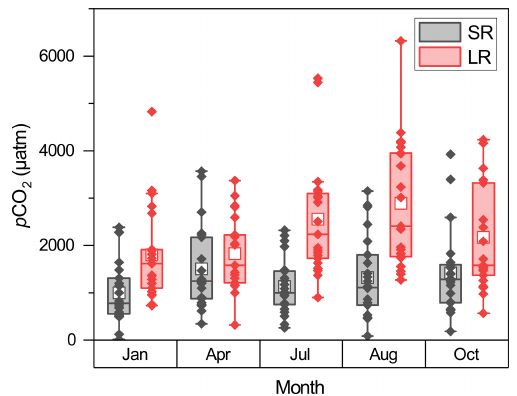
Figure 4. Seasonal p CO 2 changes in small and large rivers. The box mid-lines represent medians; the interquartile range (IQR) is represented by the top and bottom of the box, respectively; whiskers indicate the range of 1.5 IQR; the white square symbols represent means, and the other symbols represent p CO 2 values for each sam- pled